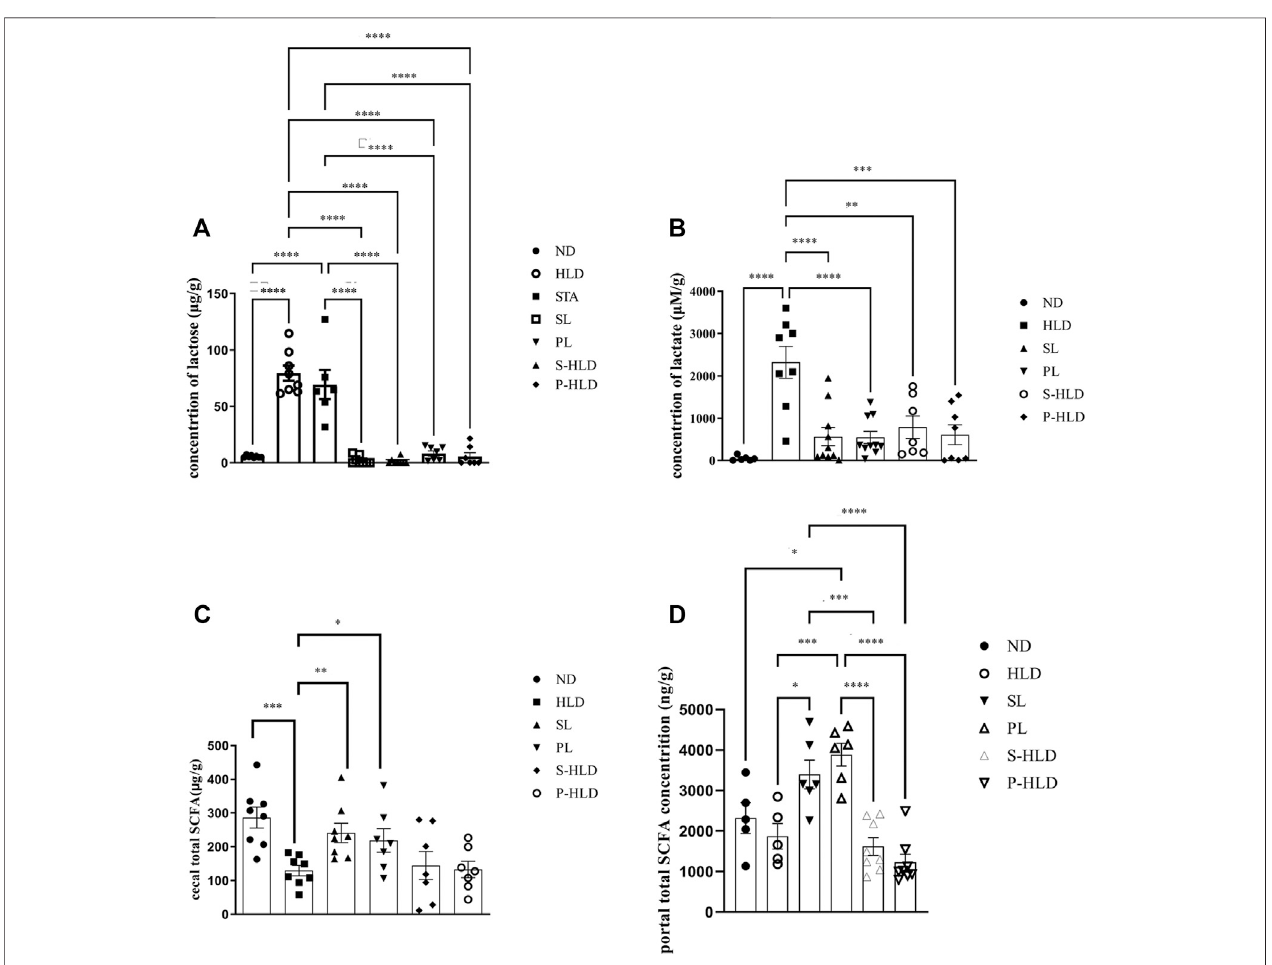
FIGURE 6 | Concentration of cecal lactose (A) , lactic acid (B) , SCFA (C) and portal SCFA (D) under different treatments. Statistical signi fi cance was determined using a 2-tailed unpaired Student ’ s t test for two groups or one-way ANOVA for many groups, followed by Tukey ’ s test. * p ≤ 0.05, ** p ≤ 0.01, *** p ≤ 0.001, and **** p ≤ 0.0001, n = 6-8 per